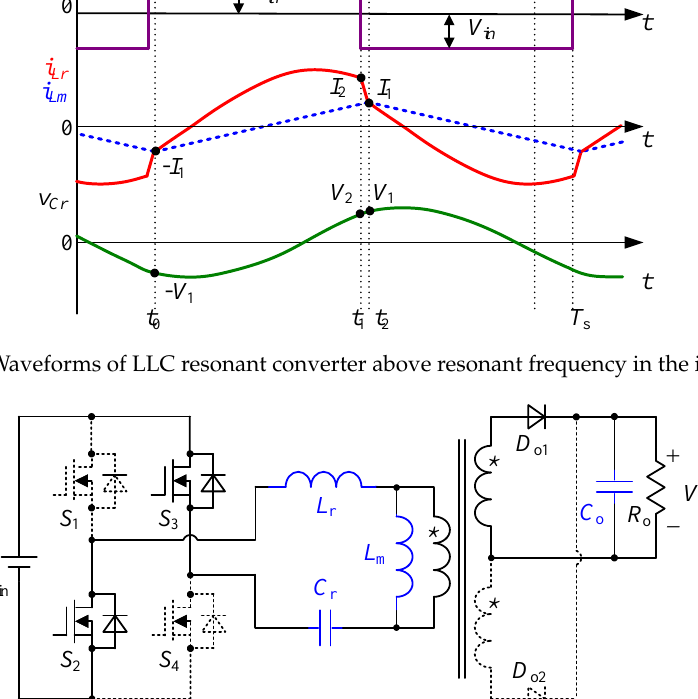
Figure 8. Equivalent circuit of the negative resonant stage of LLC resonant converter.